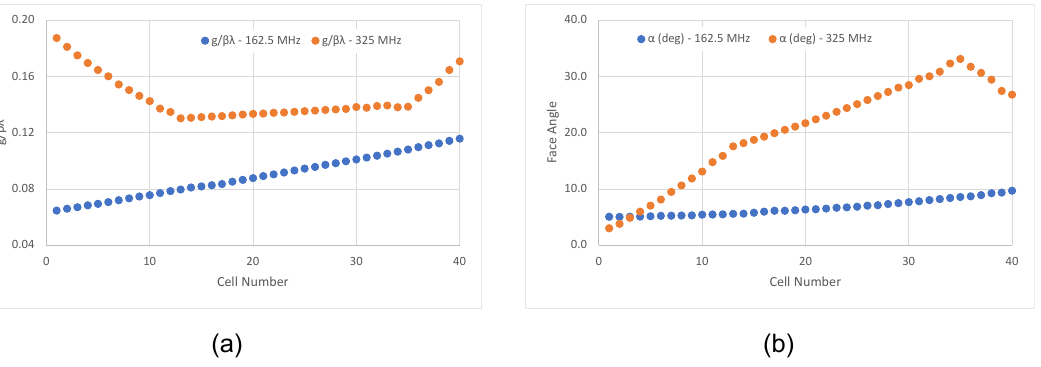
Figure 7. Gap-to-cell-length ratio ( a ) and face angle ( b ) variations as a function of cell number required to achieve the designed resonant frequencies (162.5 MHz design in blue and 325 MHz design in yellow).